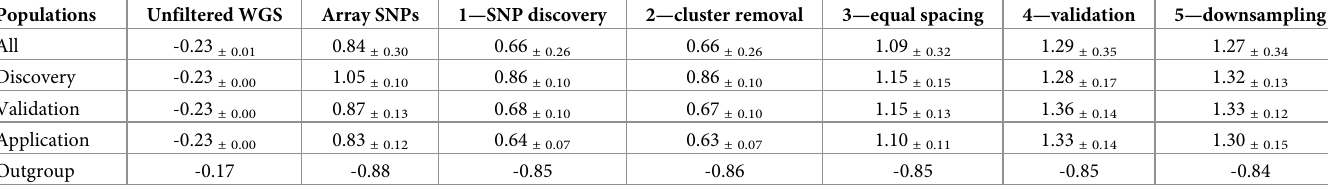
Table 1. OHE of the SNP sets from the first run. Populations Unfiltered